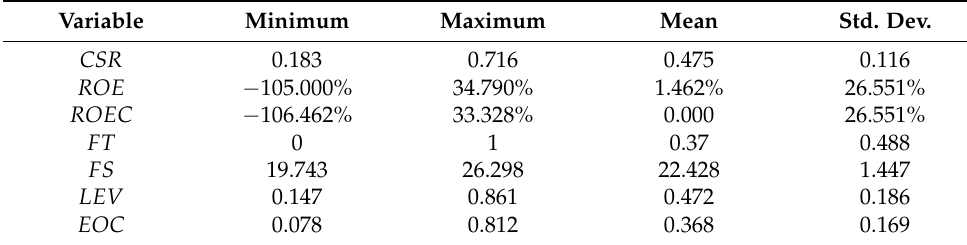
Table 4. Descriptive statistics.